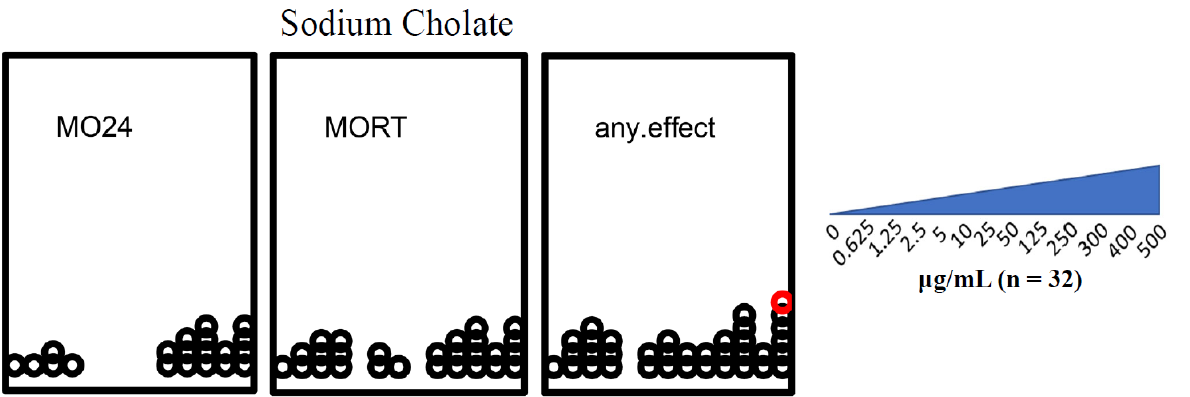
Figure 1. Developmental toxicity of sodium cholate. MO24 = 24 hpf mortality; MORT = 120 hpf mortality; any.effect = physical malformations, including mortality at 120 hpf. Outcomes signifi- cantly above the binomial threshold (Student’s t -test; α = 0.05) are indicated in red on the dot plot. The sodium cholate concentration gradient increases from left to right (0 μ g/mL, 0.625 μ g/mL, 1.25 μ g/mL, 2.5 μ g/mL, 5 μ g/mL, 10 μ g/mL, 25 μ g/mL, 50 μ g/mL, 125 μ g/mL, 250 μ g/mL, 300 μ g/mL, 400 μ g/mL, 500 μ g/mL).